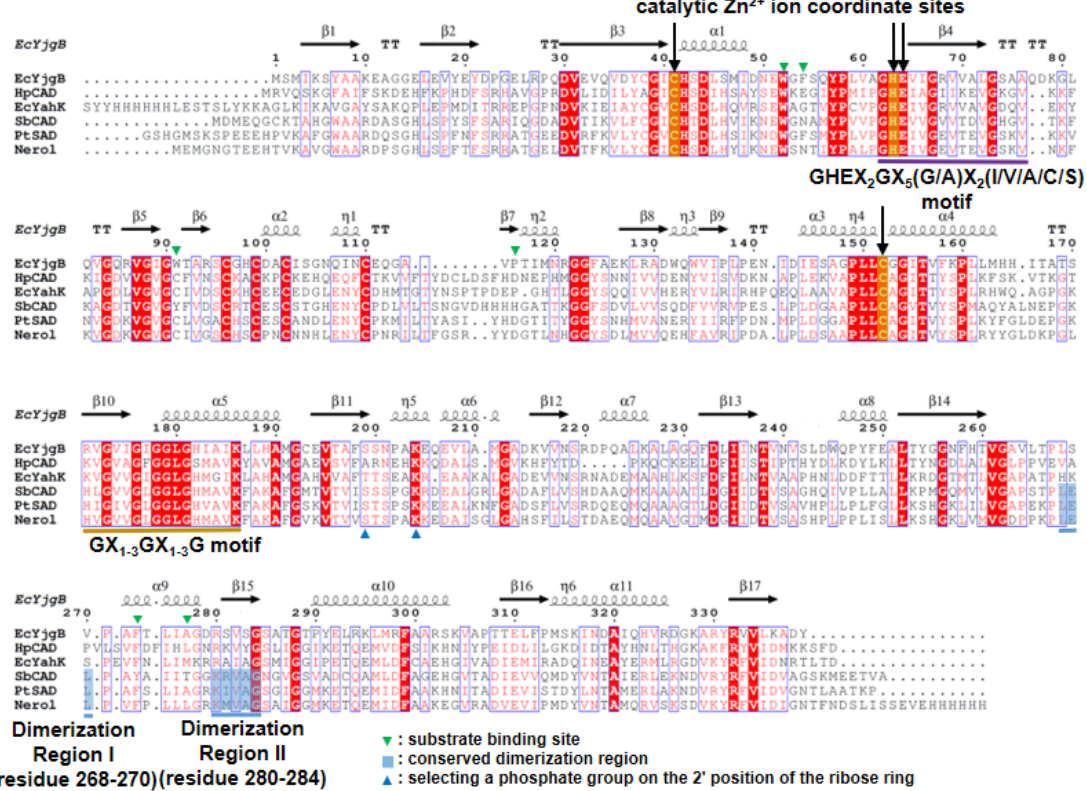
Figure 1. Sequence alignment for Ec YjgB, Hp CAD, Ec YahK, Sb CAD, Pt CAD, and Nerol. Sequences of Ec YjgB, Escherichia coli BL21 (DE3) YjgB (B21_04099); Hp CAD, Helicobacter pylori cinnamyl alcohol